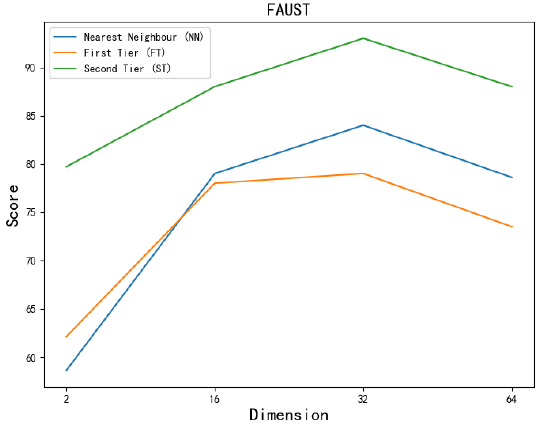
Figure 17. Retrieval performance with different dimensions of descriptors on the FAUST dataset.